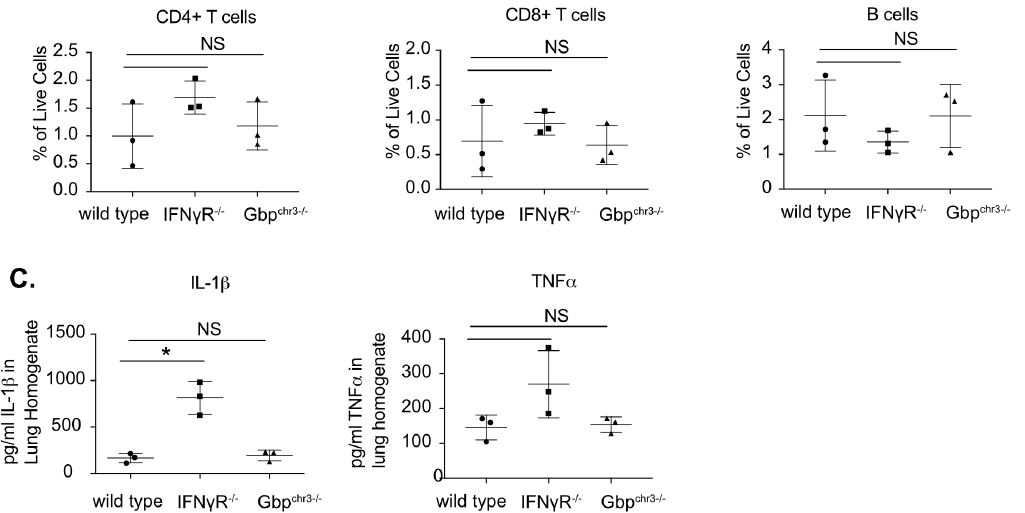
Figure 4. Chromosome 3 GBPs do not control the host response to M. tuberculosis infection. ( A ) BMDMs from wild type, IFN γ R / − or Gbp chr3 − / − mice were stimulated with IFN γ overnight then infected with Mtb for 4 h then washed with fresh media. 18 h later, (Left) supernatants were harvested and the levels of IL1 β and TNF α were quantified in the supernatants by ELISA. Shown is the mean of four biological replicates normalized to a standard curve ± SD ** p < 0.01, NS no significance. (Right) cells viability was quantified and normalized to uninfected IFN γ -activated cells. Shown is the mean of three biological replicates ± SD. ( B , C ) 28 days following low-dose aerosol infection with H37Rv (day 0 of ~50–100 CFU), the lungs of wild type, IFN γ R / − , and Gbp chr3 − / − mice were harvested and the immune cell populations were quantified by flow cytometry and cytokines were quantified by ELISA. For ( B ), we determined the % of live cells for Granulocytes (CD45 + CD11b + Ly6G + ), Macrophages (CD45 + CD11b + Ly6G − ), Dendritic Cells (CD45 + CD11b − Ly6G − CD11c + ), CD4 + T cells (CD45 + CD4 + ), CD8 + T cells (CD45 + CD8 + ) and B cells (CD45 + B220 + ). For ( C ) Cytokines quantified from lung homogenates. Shown is the mean of three mice per group ± SD * p < 0.05 ** p < 0.01, NS no significance. These data are representative of 3–4 independent experiments with similar results.